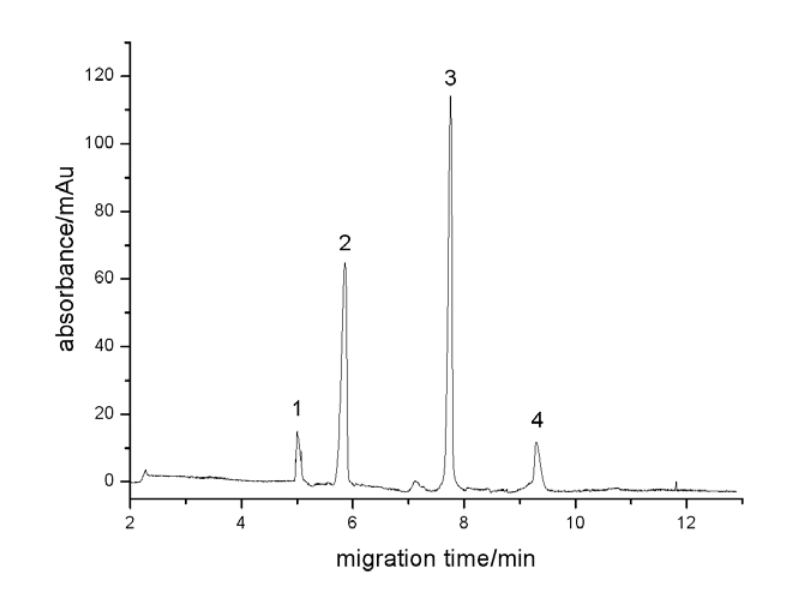
Fig. 3 Capillary electropherogram of a standard mixture. Peaks: 1 = EOF marker; 2 = paeoniforin; 3 = paeonol; 4 = censenoside Rg 1 . Analytical conditions: 20 mM borax, 30 mM SDS, pH 9.30, applied voltage 20 kV, sample time 5 s, detection UV 203